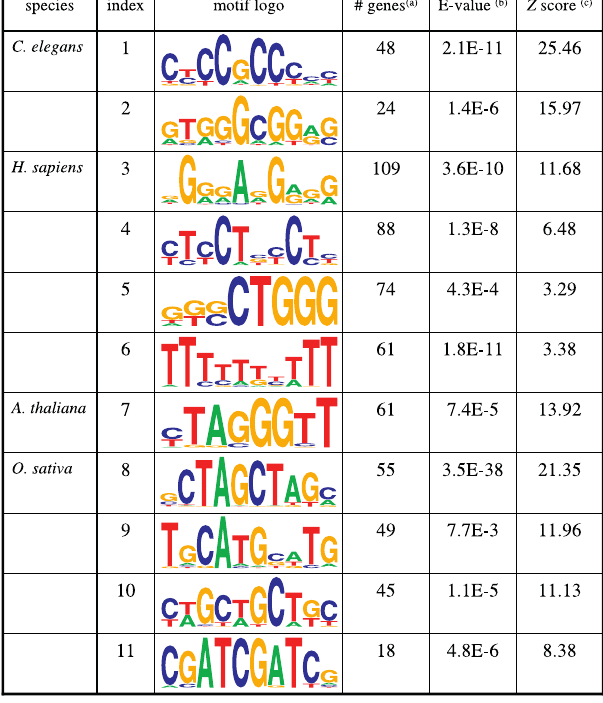
Figure 4. Significant Species-Specific Motifs Discovered in the Putative Promoters of MicroRNA Genes in Four Species. (A–C) The same as in Figure 2.